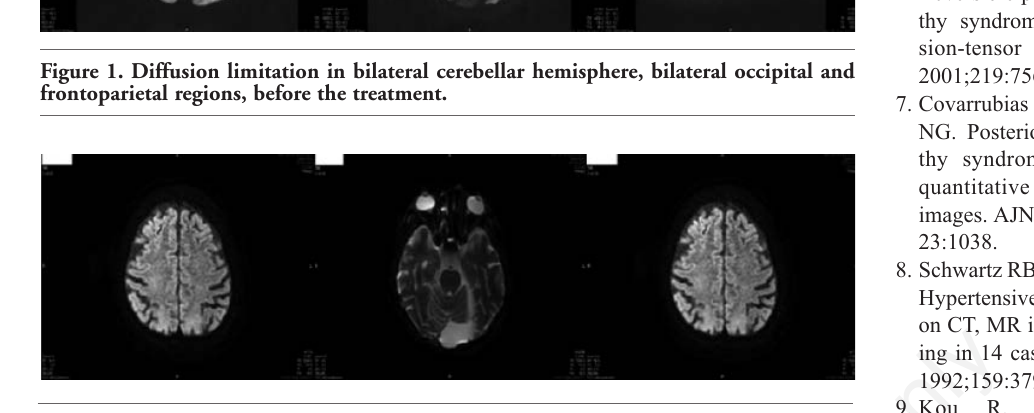
Figure 2. Regression of PRES lesions was observed compared to previous MR